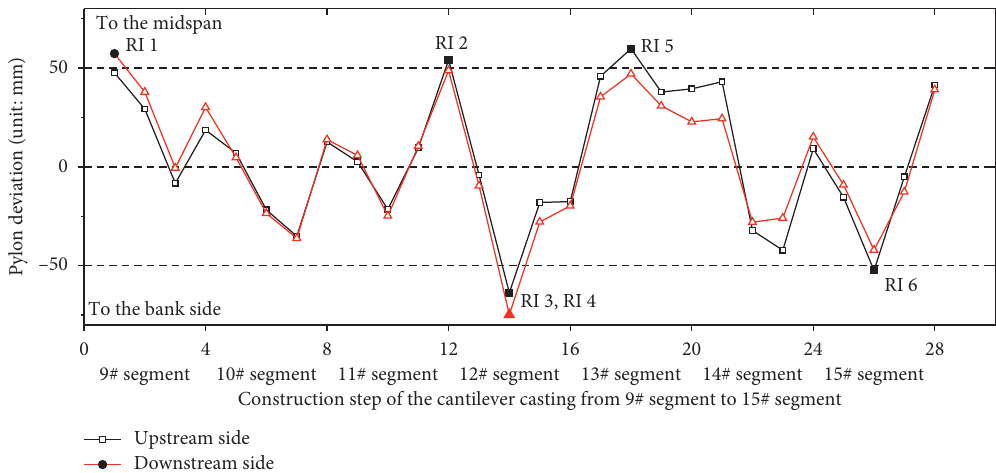
Figure 8: Field test of the automatic deviation-rectifying control system in safety control of the west bank cantilever casting construction of the Shatuo Bridge (unit: mm). RI denotes that automatic rectification intervention was initiated. The installation of each box-type segment is composed of four tensioning construction steps, before casting, after casting, before tensioning, and after tensioning, and the designed tension forces were predetermined by the construction design.